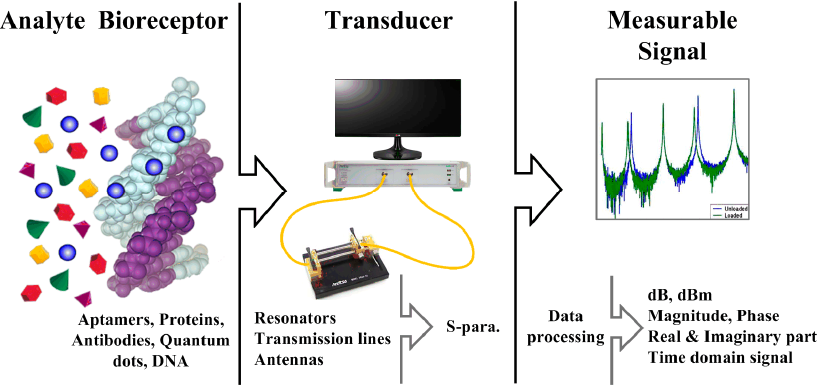
Figure 4. Basic concept of radio-frequency (RF)/microwave biosensors (reprinted with permission from [53]).